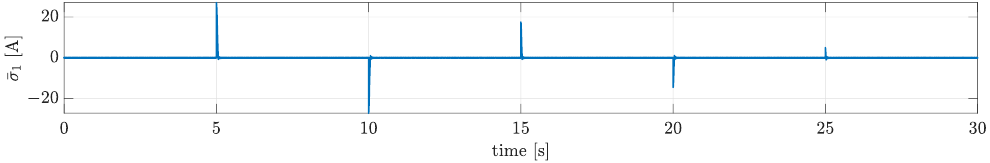
Figure 7. Boost mode. Sliding variable ¯ σ 1 in